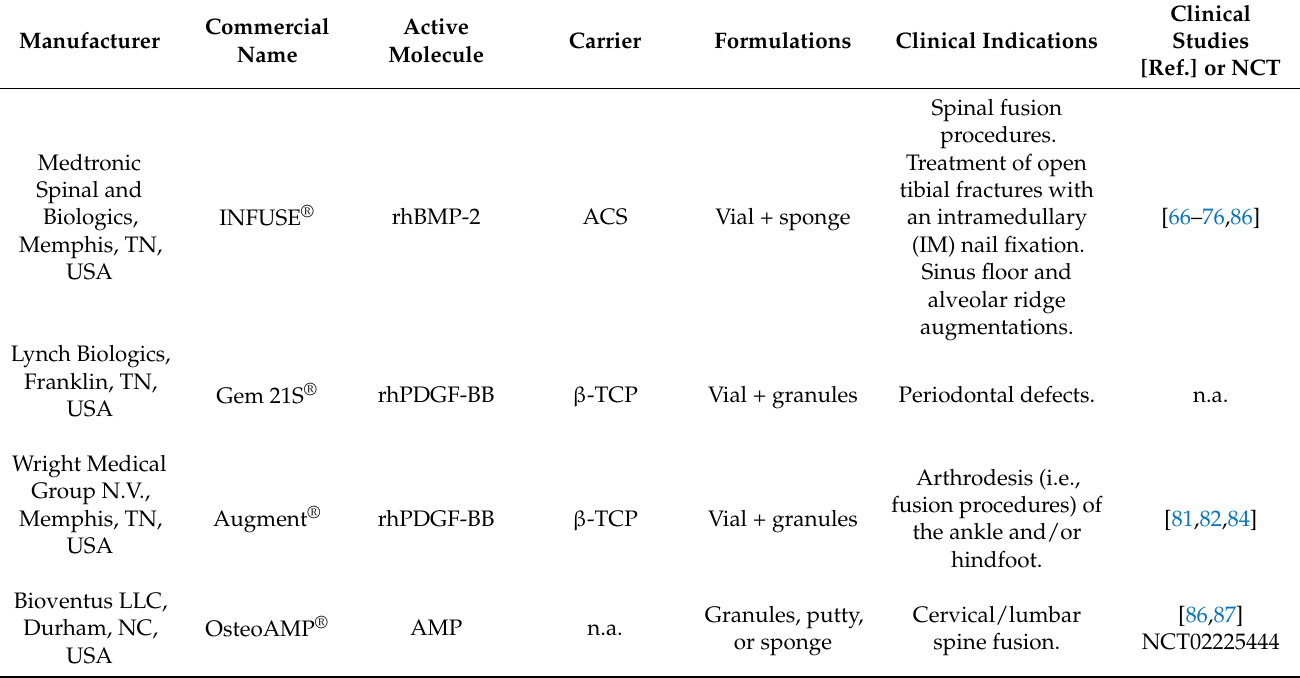
Table 2. Summary of growth factor enhanced bone grafts commercially available for